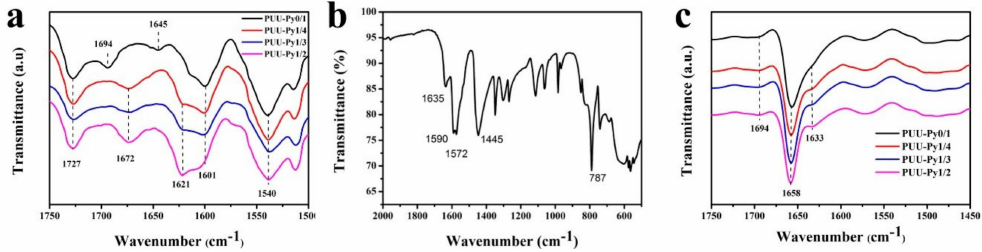
Figure 2. FTIR spectra of PUU-Pyfrom ( a ) bulk elastomer and ( b ) 2,6-diaminopyridine; ( c ) FTIR spectra of various PUU-Py elastomers from